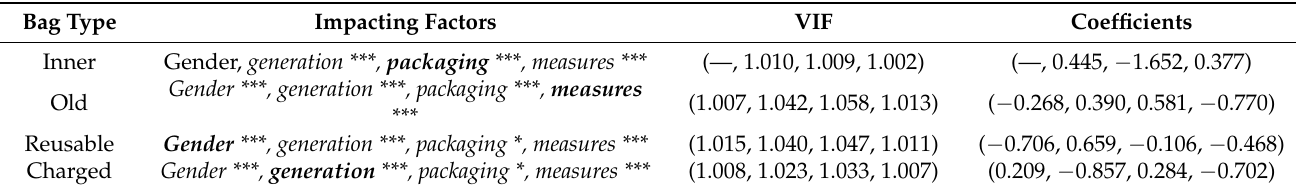
Table 3. The logistic regression results of influential factors on people’s usage of different